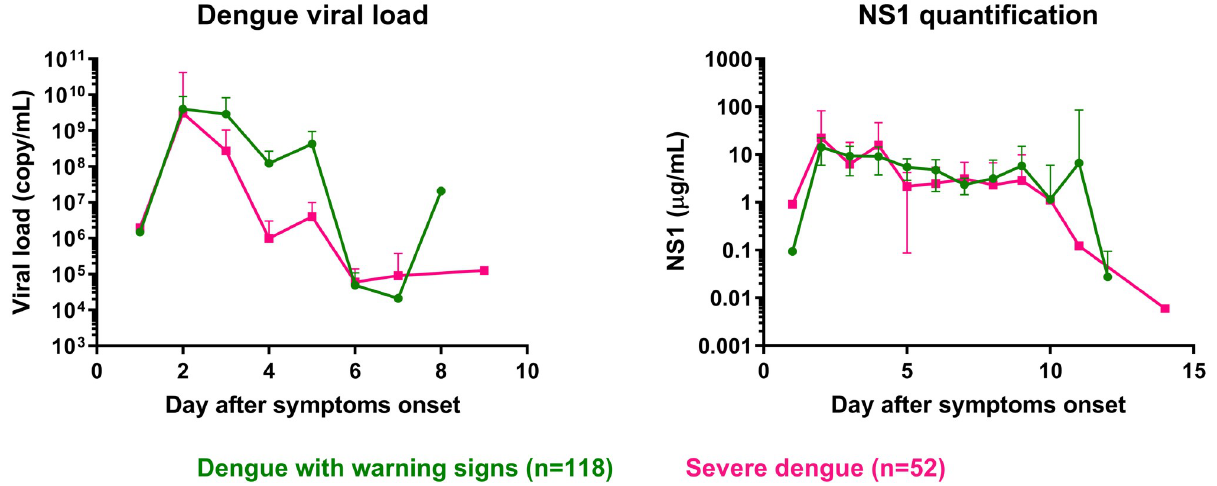
Fig 1. Dengue viral load at admission and NS1 antigen levels during hospitalization in dengue-infected patients using the adapted WHO 2009 classification scheme. Dengue with warning signs (DWWS; green circles), severe dengue (SD; pink squares). Error bars correspond to the 95% confidence interval around the